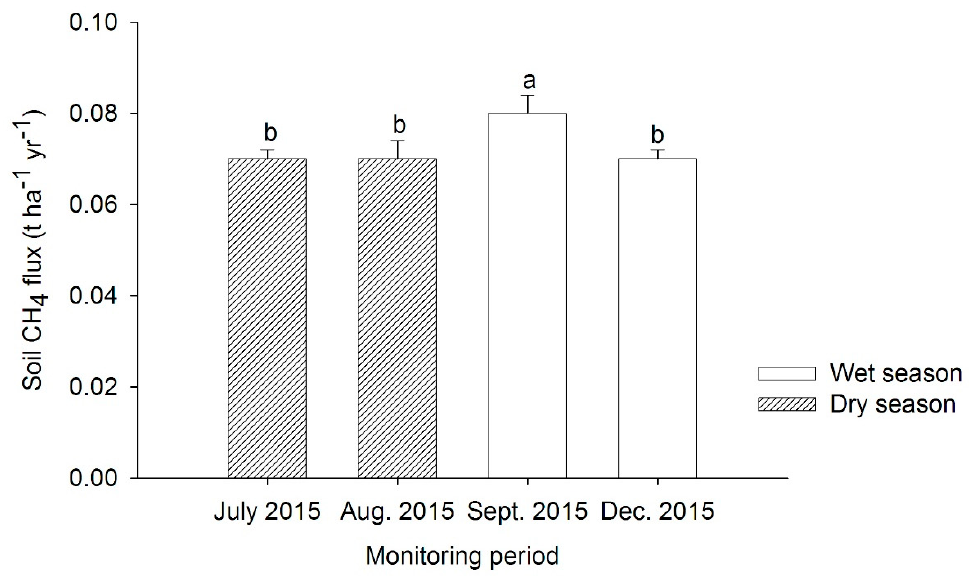
Figure 7. Averaged soil CH 4 emissions over 24 h from a tropical peat soils cultivated with pineapple throughout the dry (July and August 2015) and wet (September and December 2015) seasons. Error bars represent standard error and soil mean fluxes with different letters are significantly different using DNMRT at p ≤ 0.05. Table 1. Relationship between soil CH 4 emission and soil temperature from a peat soil cultivated with pineapples through- out the dry and wet seasons in 2015 .